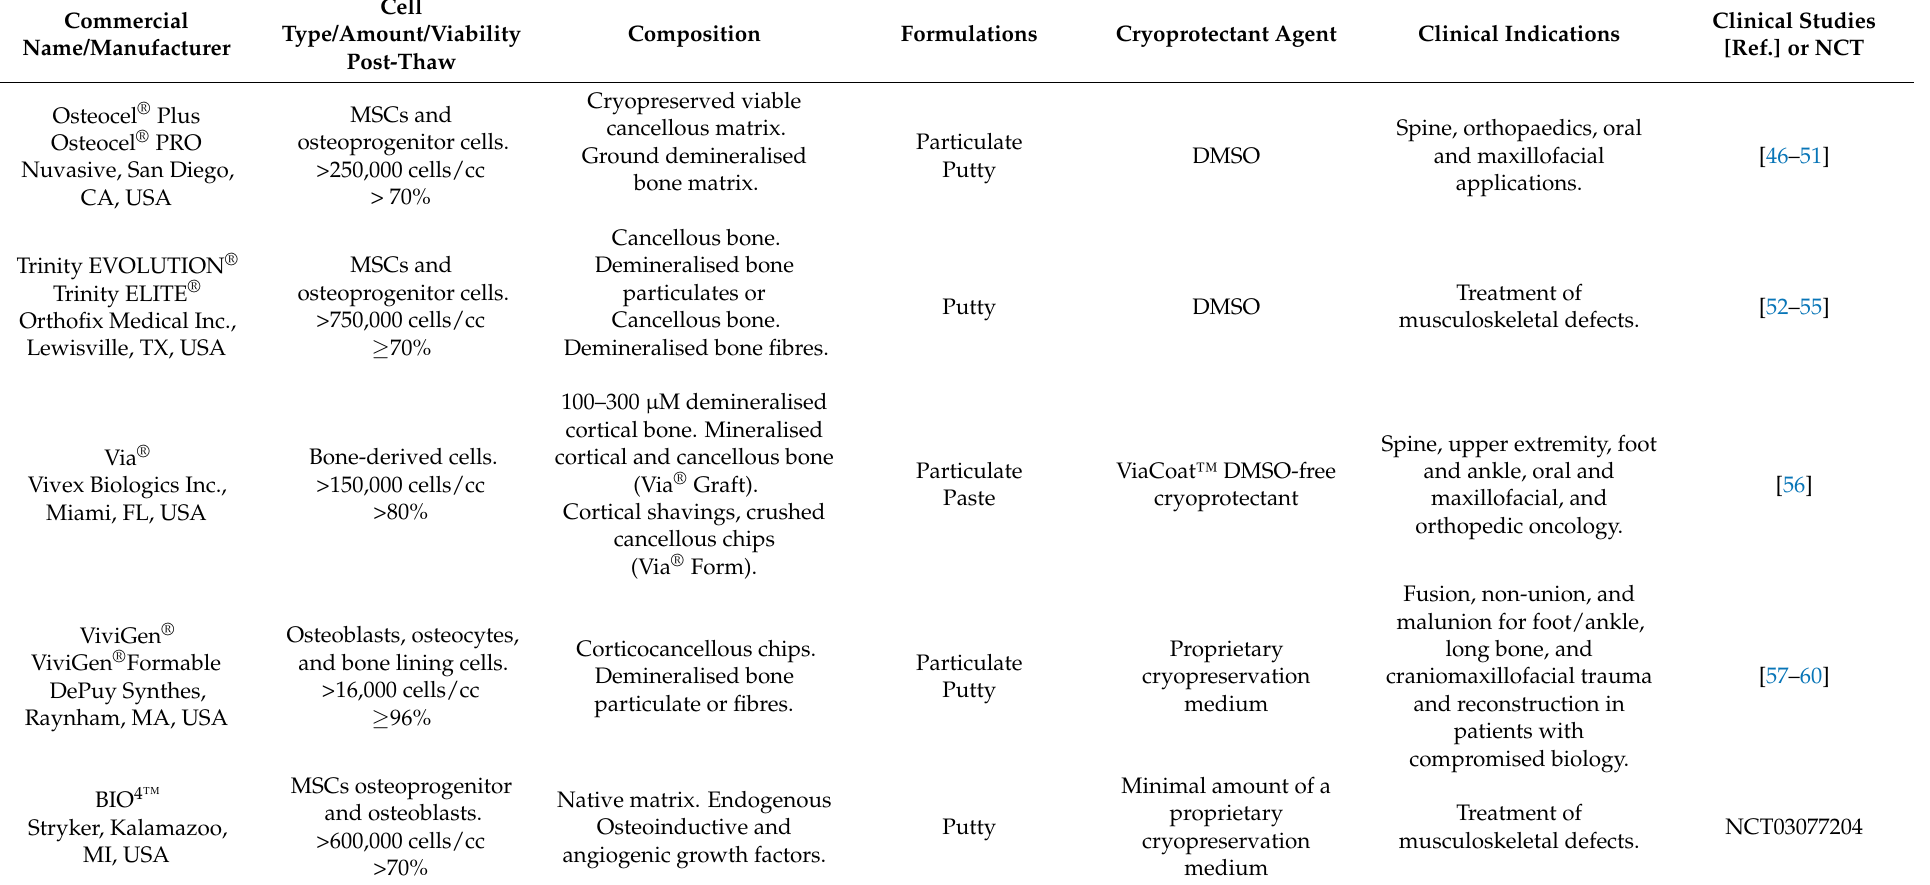
Table 1. Summary of cellular bone matrices commercially available for